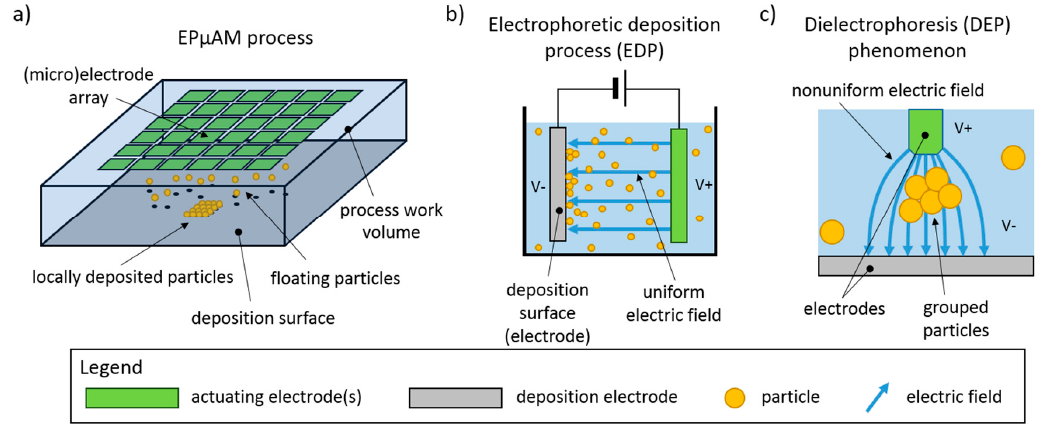
Figure 1. ( a ) EP µ AM process schematic; ( b ) electrophoretic deposition process (EDP); and ( c ) dielectrophoresis phenomenon (DEP).